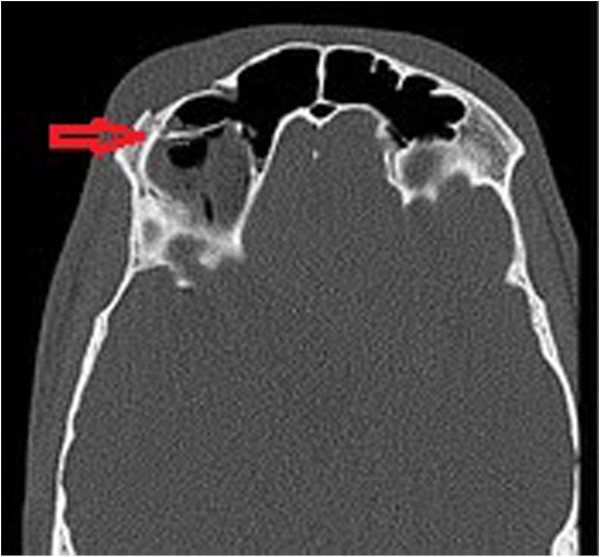
CT facial bones.